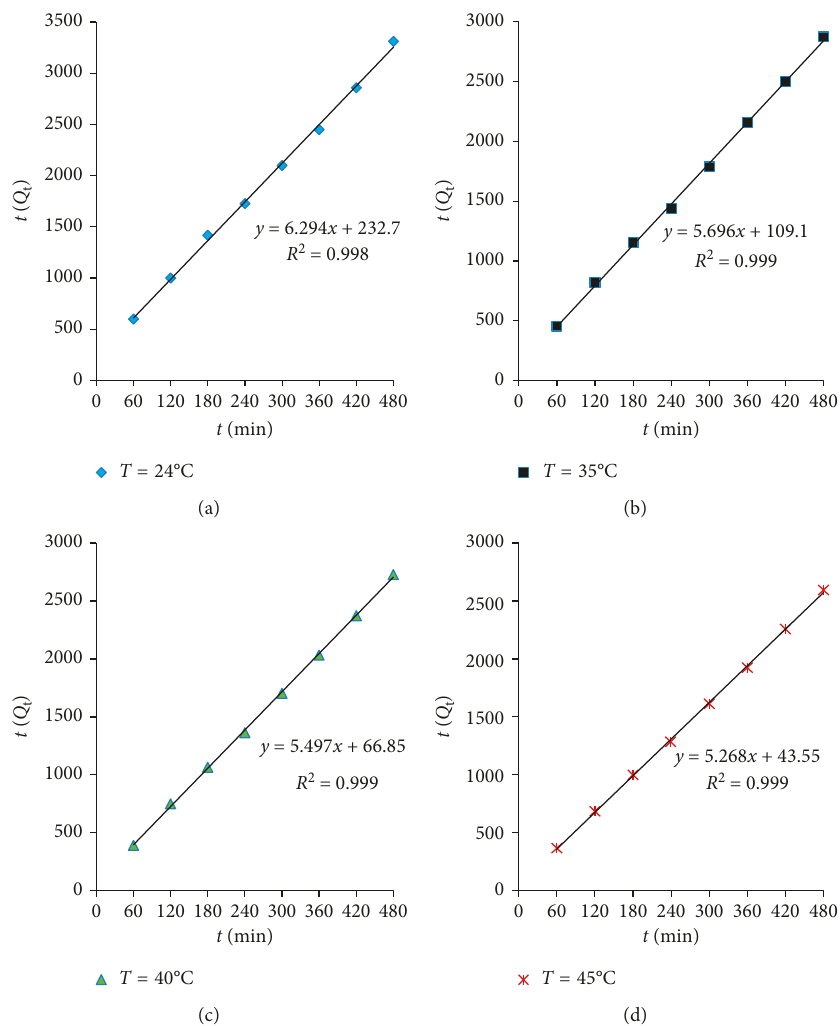
Figure 8: Linear representations of the pseudo-second-order kinetic model at different temperatures, pH � 9.6, V phorus concentration �